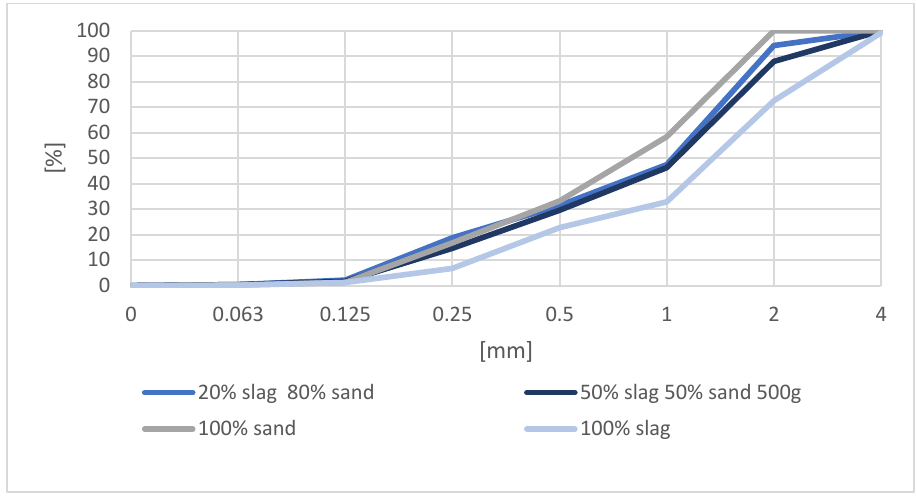
Figure 5. Aggregate grain size curve.